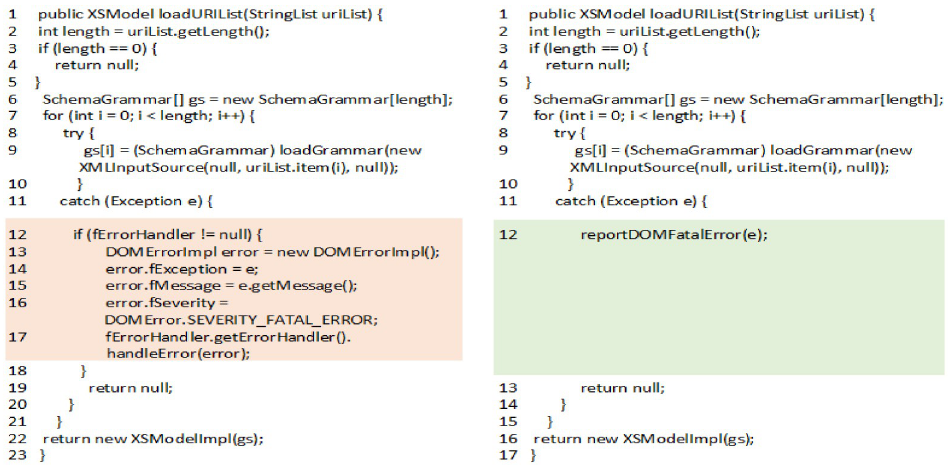
Fig 1. Example of clone refactoring in